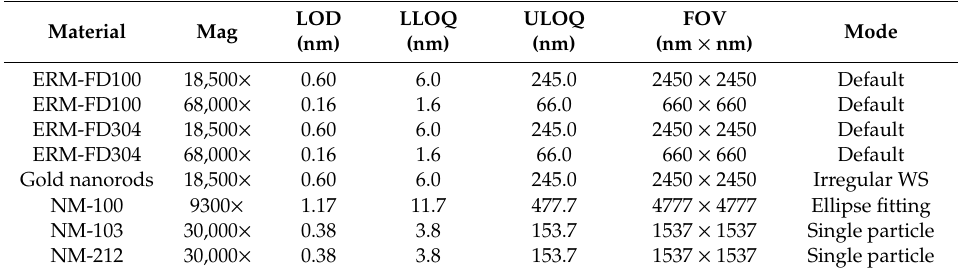
Table 1. Summary of imaging and image analysis